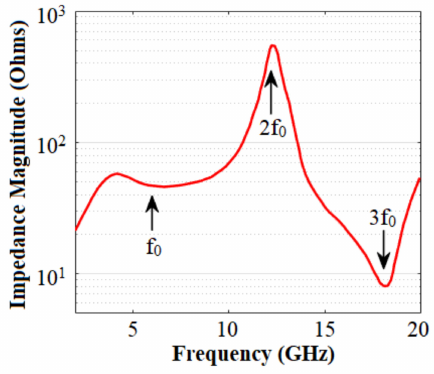
Figure 4. Impedance trace as a function of